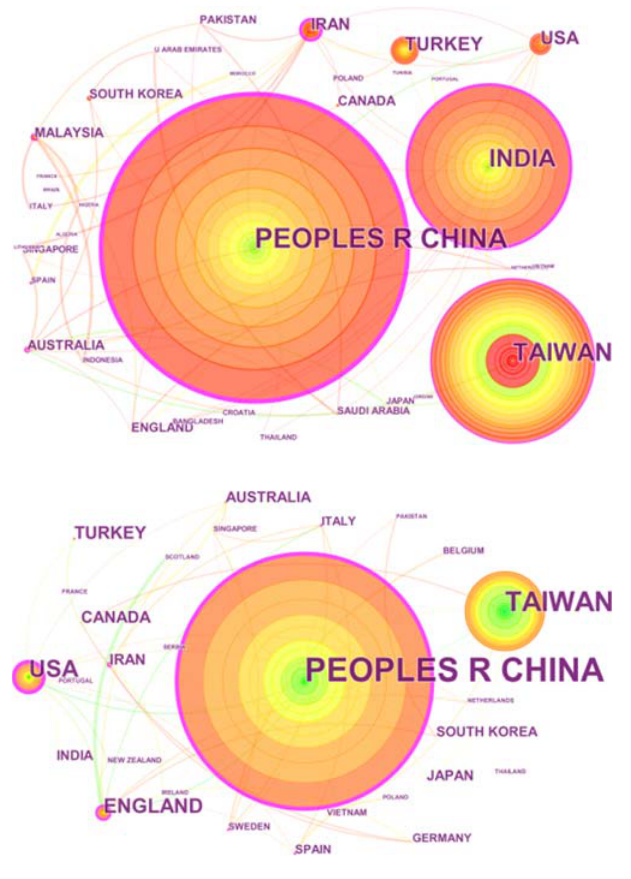
Figure 5. Network of